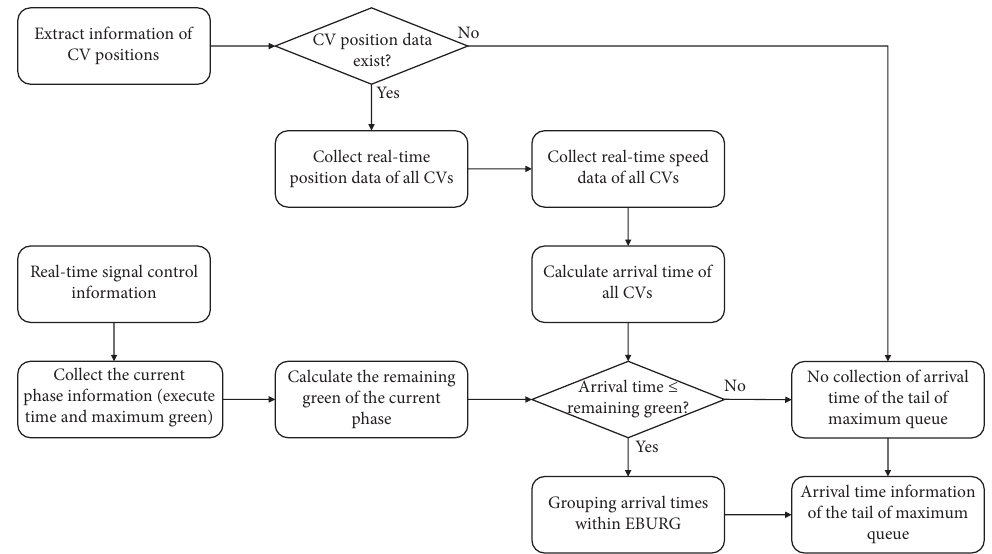
Figure 4: Intersection arrival time estimation algorithm.